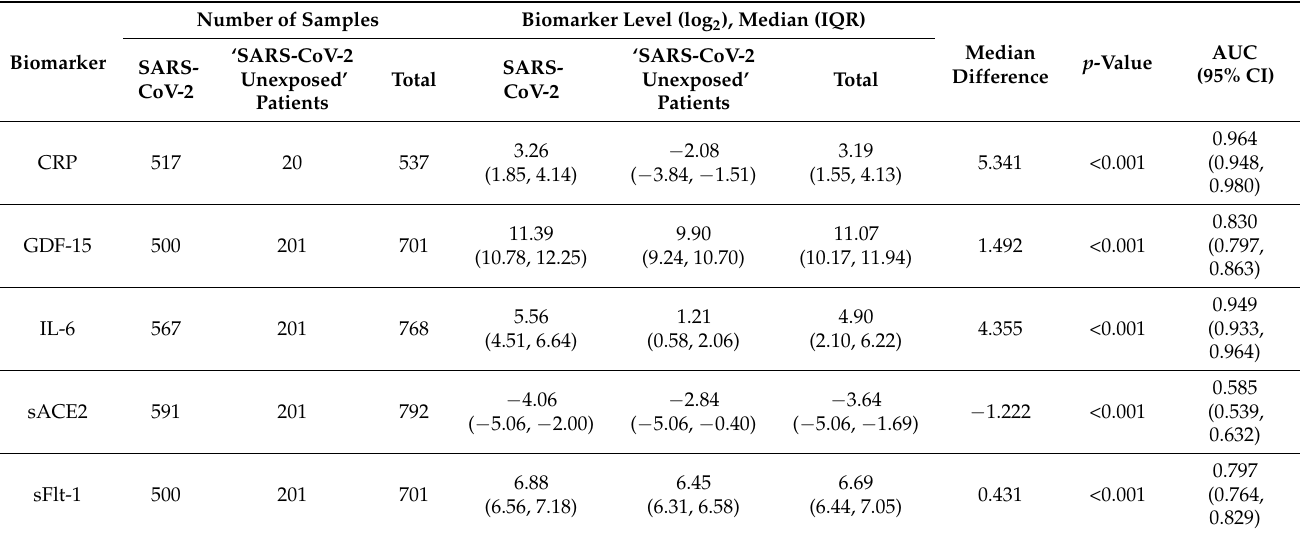
Table 3. Overview of differences in biomarker levels between patients with SARS-CoV-2 infection (Groups 1–4) and ‘SARS-CoV-2 unexposed’ patients (Group